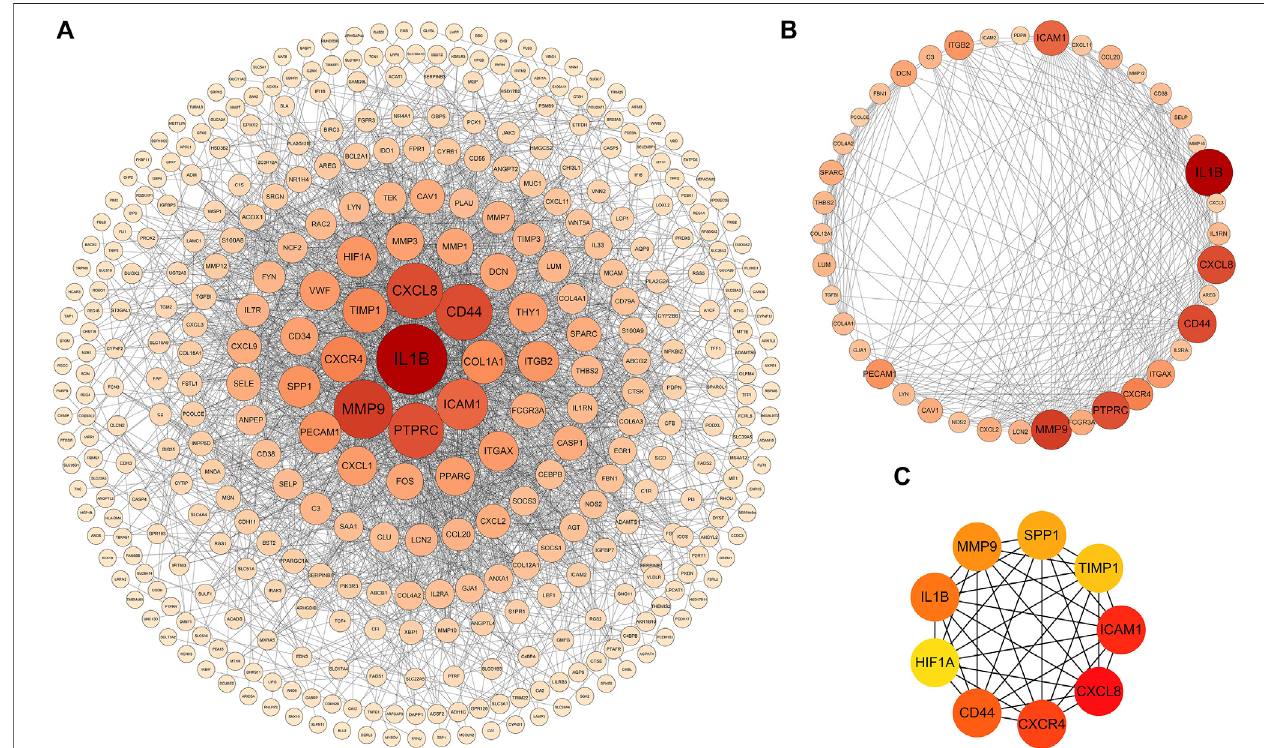
FIGURE 4 | PPI networks of 309 up-regulated genes and 137 down-regulated genes by Cytoscape. The network consists of 446 nodes and 2163 edges. Two edgesbetweennodes represent theinteractionsbetweengenes. Each genecorrespondingto thenode is sized and colored accordingto thedegree of interaction. The color grade indicates the change in the degree of each gene from high (orange-red) to low (faint yellow). The nearer the red node, the higher the connection between the Twonodes (A) .ThedensestconnectedregioninthePPInetwork(40nodes,275edges)wasidenti fi edusingMCODE (B) .UsingtheMCCalgorithmincytoHubba, 9 hub genes were identi fi ed in the densest connected regions. The scores are shown in red color. A darker color means a higher score (C) .